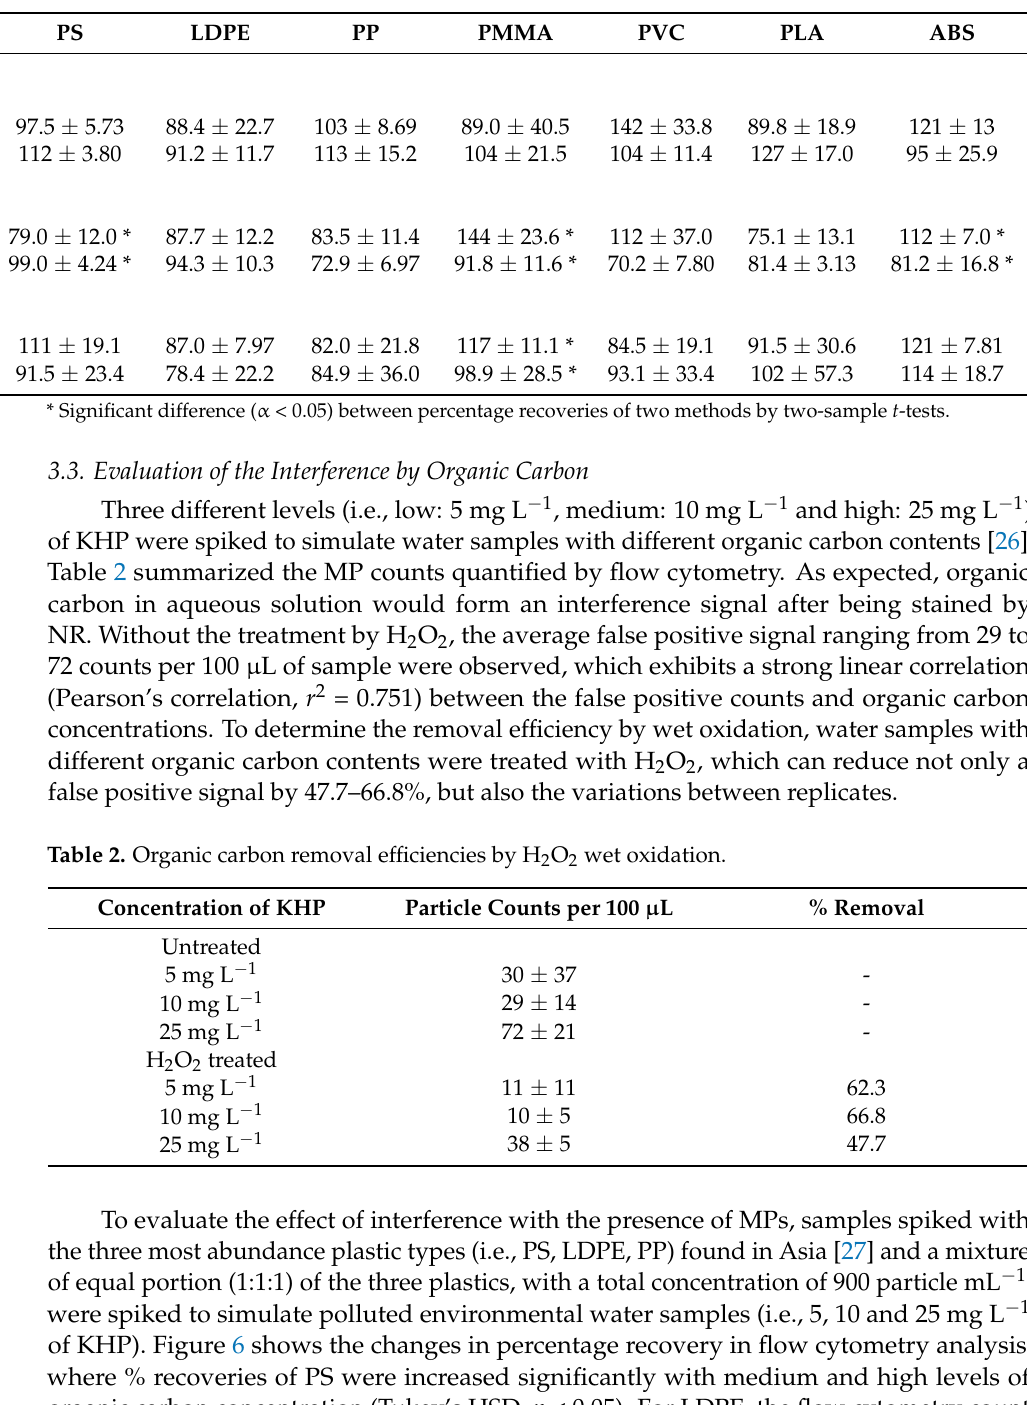
Table 1. Comparison of percentage recoveries between flow cytometry and visual microscopic identification of NR-stained MPs. Data presented were mean values and standard deviation of five replicates.